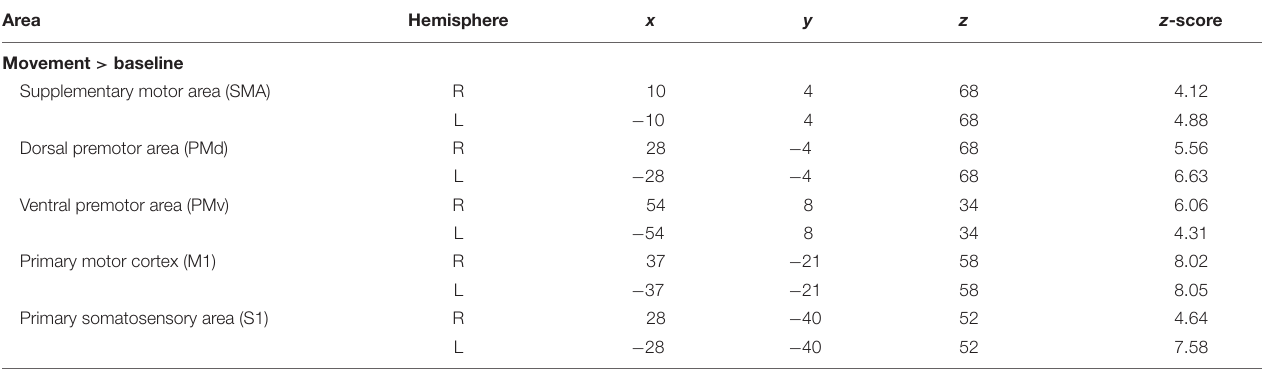
TABLE 1 | Regions defined for the resting state motor network.